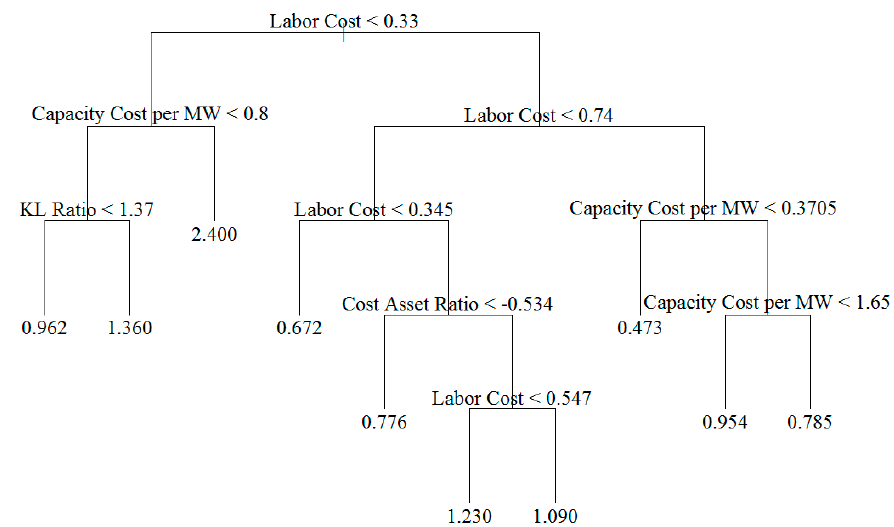
Figure 5. Bootstrapped regression tree thresholds.